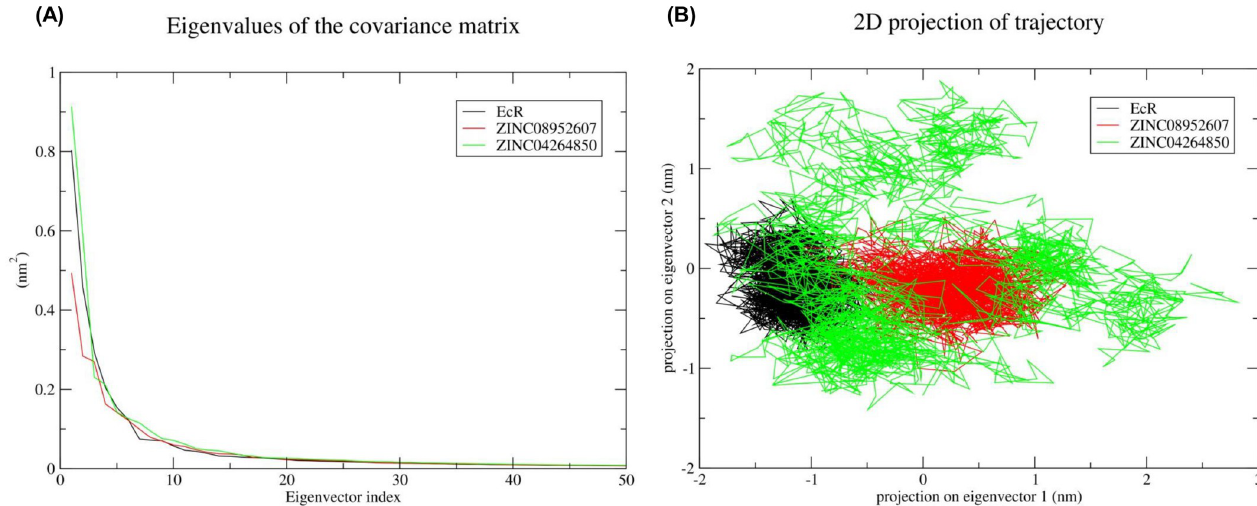
Fig 4. Principal component analysis. (A) Plot of eigen values vs eigenvector index was plotted taking into consideration the first 50 eigen vectors for BtEcR, BtEcR-ZINC08952607, and BtEcR-ZINC04264850. (B) Projection of protein motion in phase space along PC1 and PC2 for BtEcR, BtEcR-ZINC08952607, and BtEcR-ZINC04264850. Black, red and green color represent BtEcR, BtEcR-ZINC08952607 and BtEcR-ZINC04264850 complex, respectively.